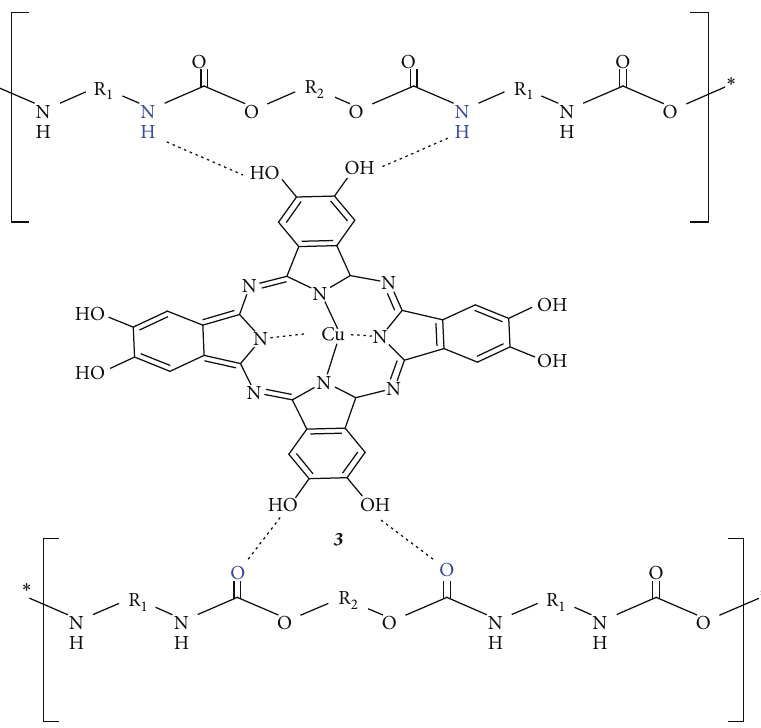
Scheme 2: The schematic of possible dispersions of CuPc in PU